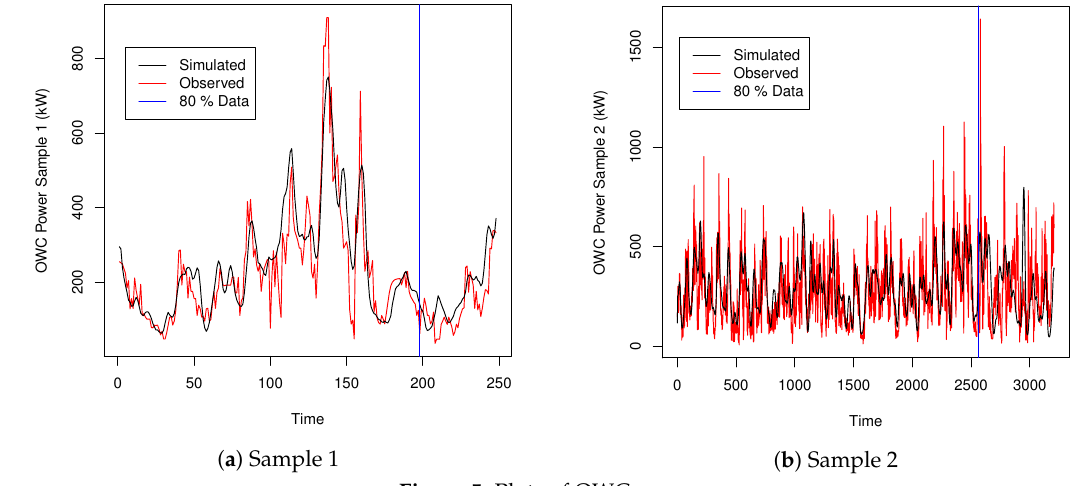
Figure 5. Plots of OWC